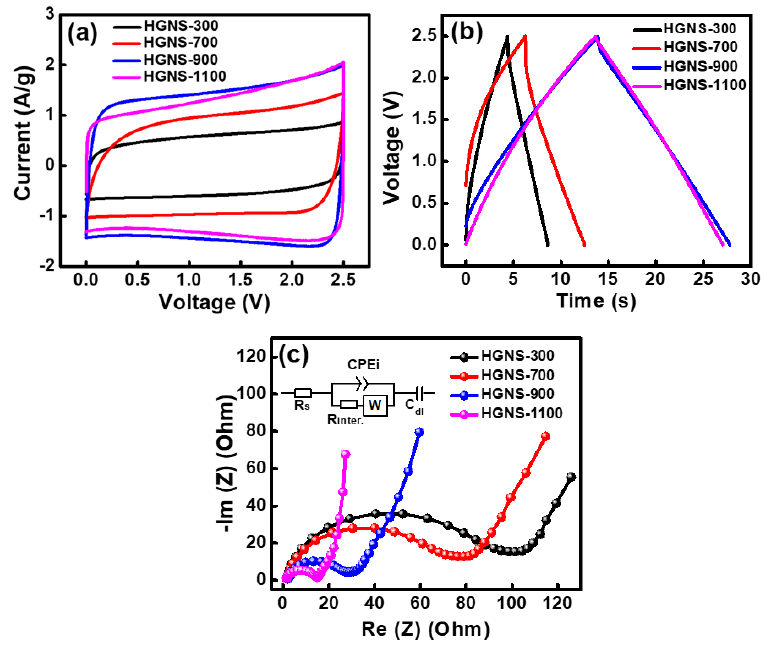
Figure 3. ( a ) CV curves of various HGNS cells measured at a potential sweep rate of 50 mV·s –1 ; ( b ) Galvanostatic charge–discharge curves of various HGNS cells measured at 5 A·g –1 ; ( c ) EIS Nyquists plots of various HGNS cells.